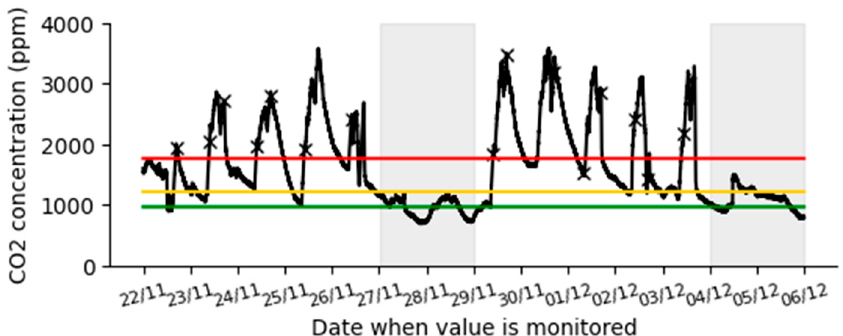
Figure 6. CO 2 concentrations evolution in Household 5 where the room is used exclusively as an office(All data monitored). Points marked with an x indicate when participant is answering an environmental comfort survey. Weekends have a grey background .